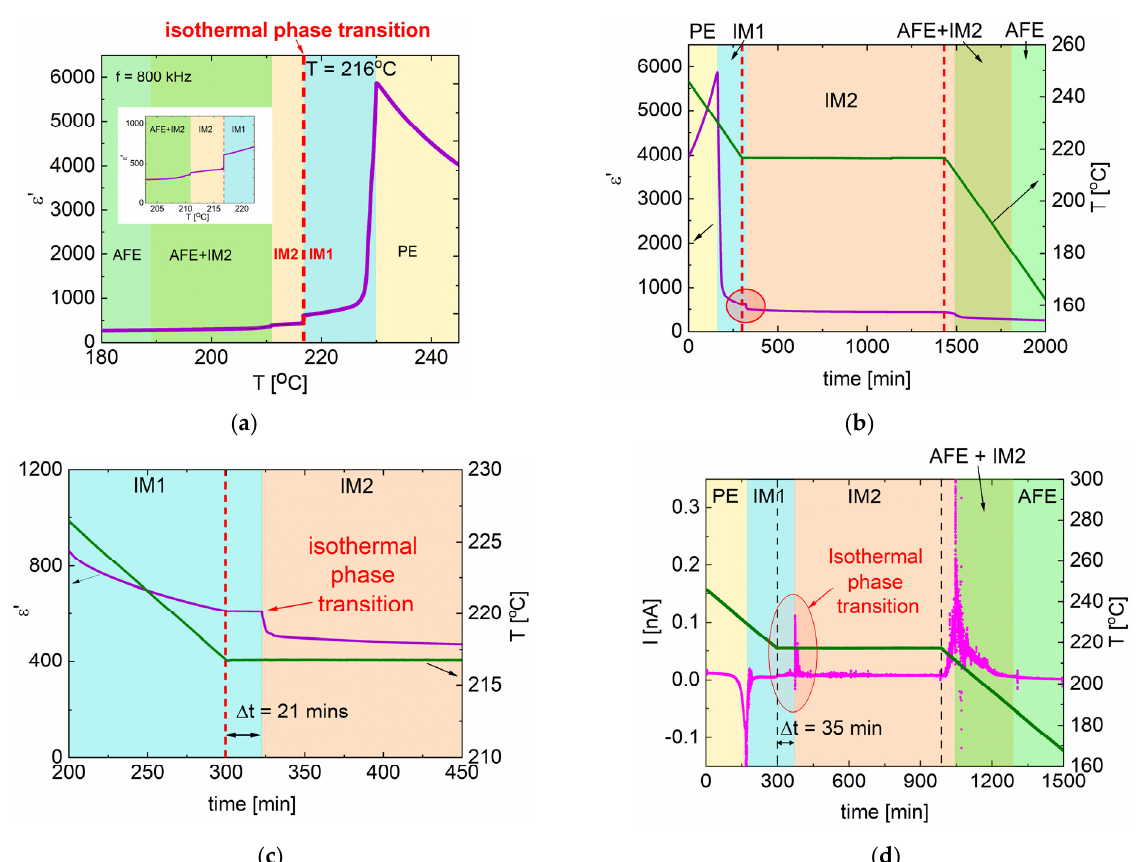
Figure 2. ( a ) Temperature changes of permittivity—the red dashed line marks the temperature at which time-dependent measurements were performed and presented in ( b , c ). ( b ) Permittivity and temperature as a function of time—the red dashed lines represent the time when the temperature was stopped at 216 °C—the red circle region is presented in ( c ). ( c ) Permittivity changes in the vicinity of the isothermal M1–M2 transition are marked as a red circle in ( b ). ( d ) Total pyroelectric current and temperature as a function of time for PbZrO 3 :0.077Nb crystal single crystal (the red circle marks the isothermal phase transition).